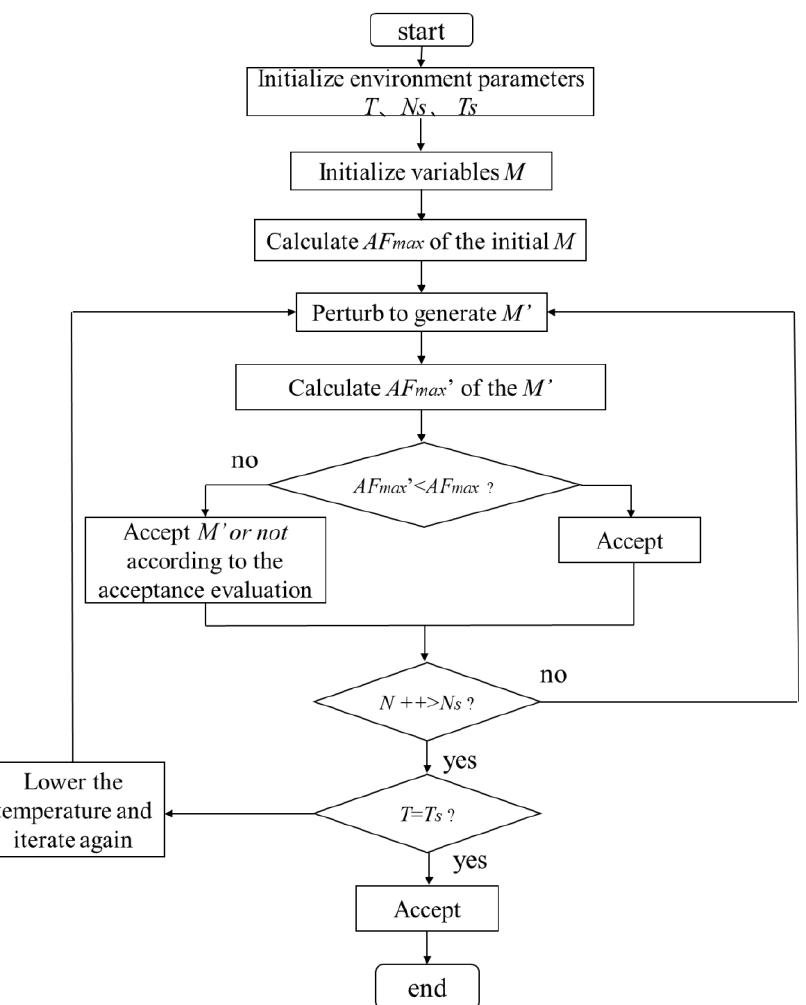
Figure 3. Flow chart of the annealing algorithm to find the optimal coding matrix ( M best ) that leads to the desired scattering field with the smallest ( AF max ) value.